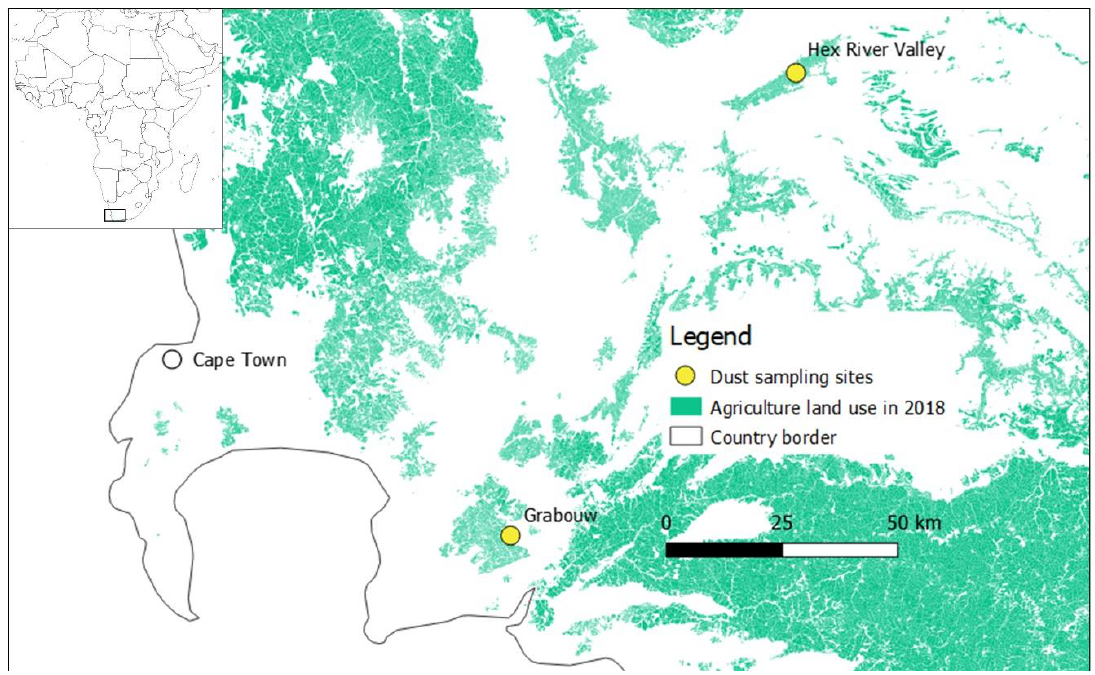
Figure 1. Map of the sampling sites.